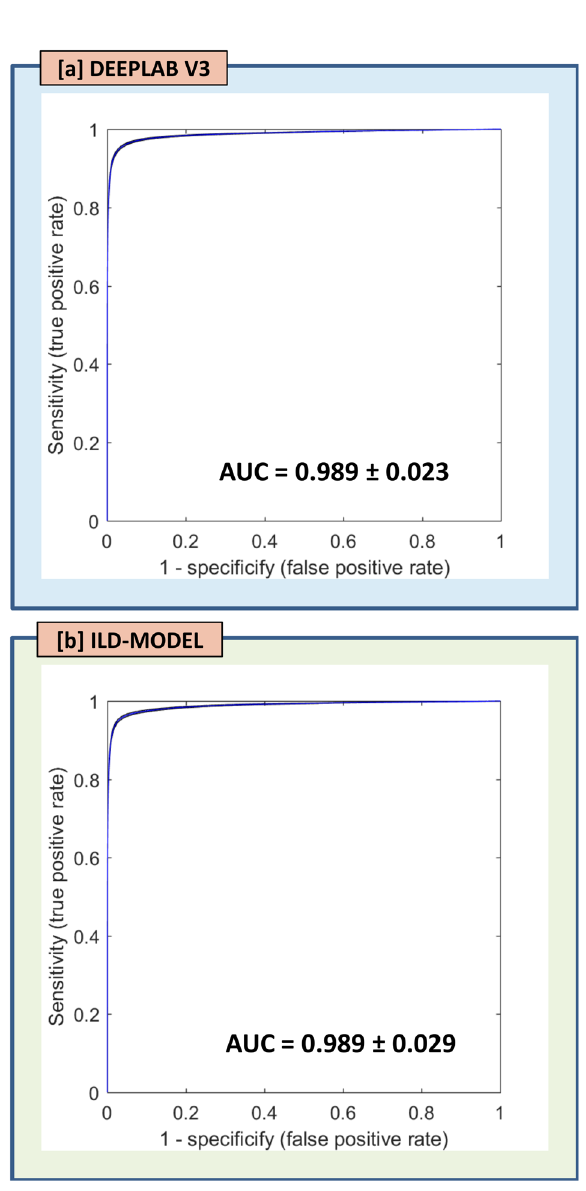
Fig. 2 Voxel-wise detection accuracy. ROC curves with 95% con fi dence interval (shaded area) averaged across all 55 test cases for the ( a ) DeepLab V3 model and the ( b ) ILD-method. The area under the ROC curve was 0.989 (ranging from 0.896 to 1.000) for the DeepLab V3 model, and 0.989 (ranging from 0.845 to 1.000) for the